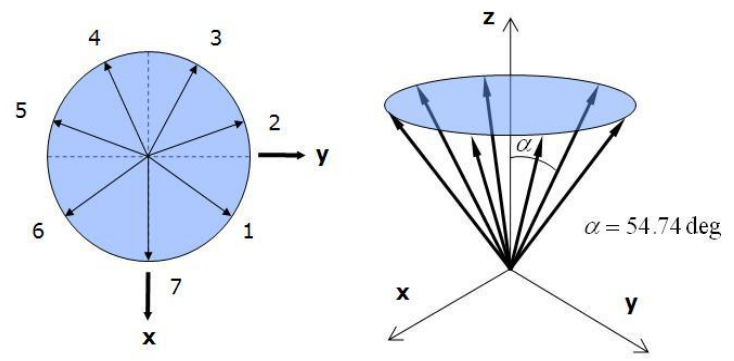
Figure 10. Redundant IMU configuration with seven sensors.